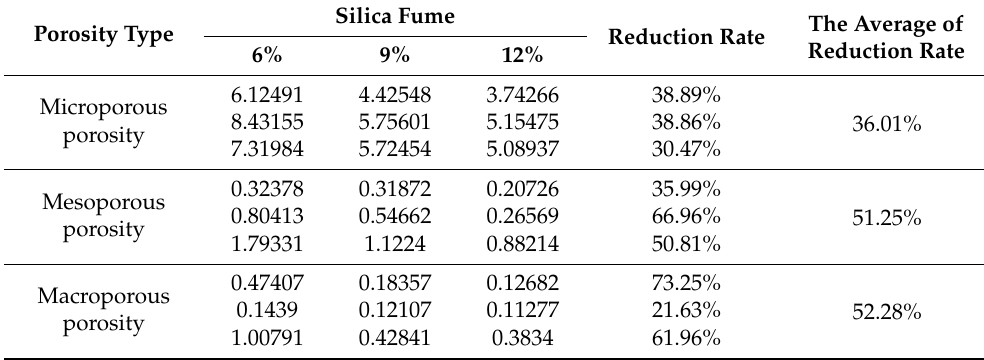
Table 5. The reduction rate of different types of